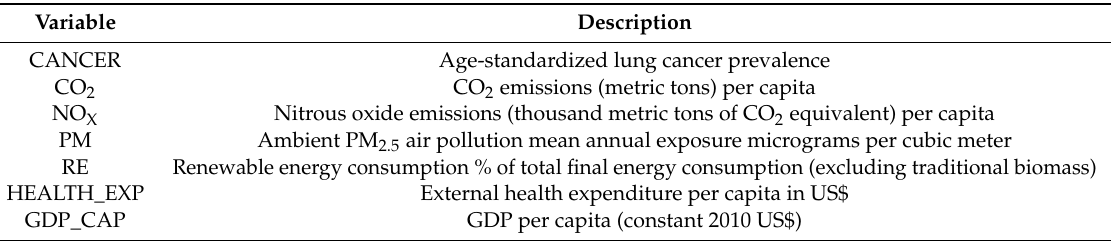
Table 1. Definition of